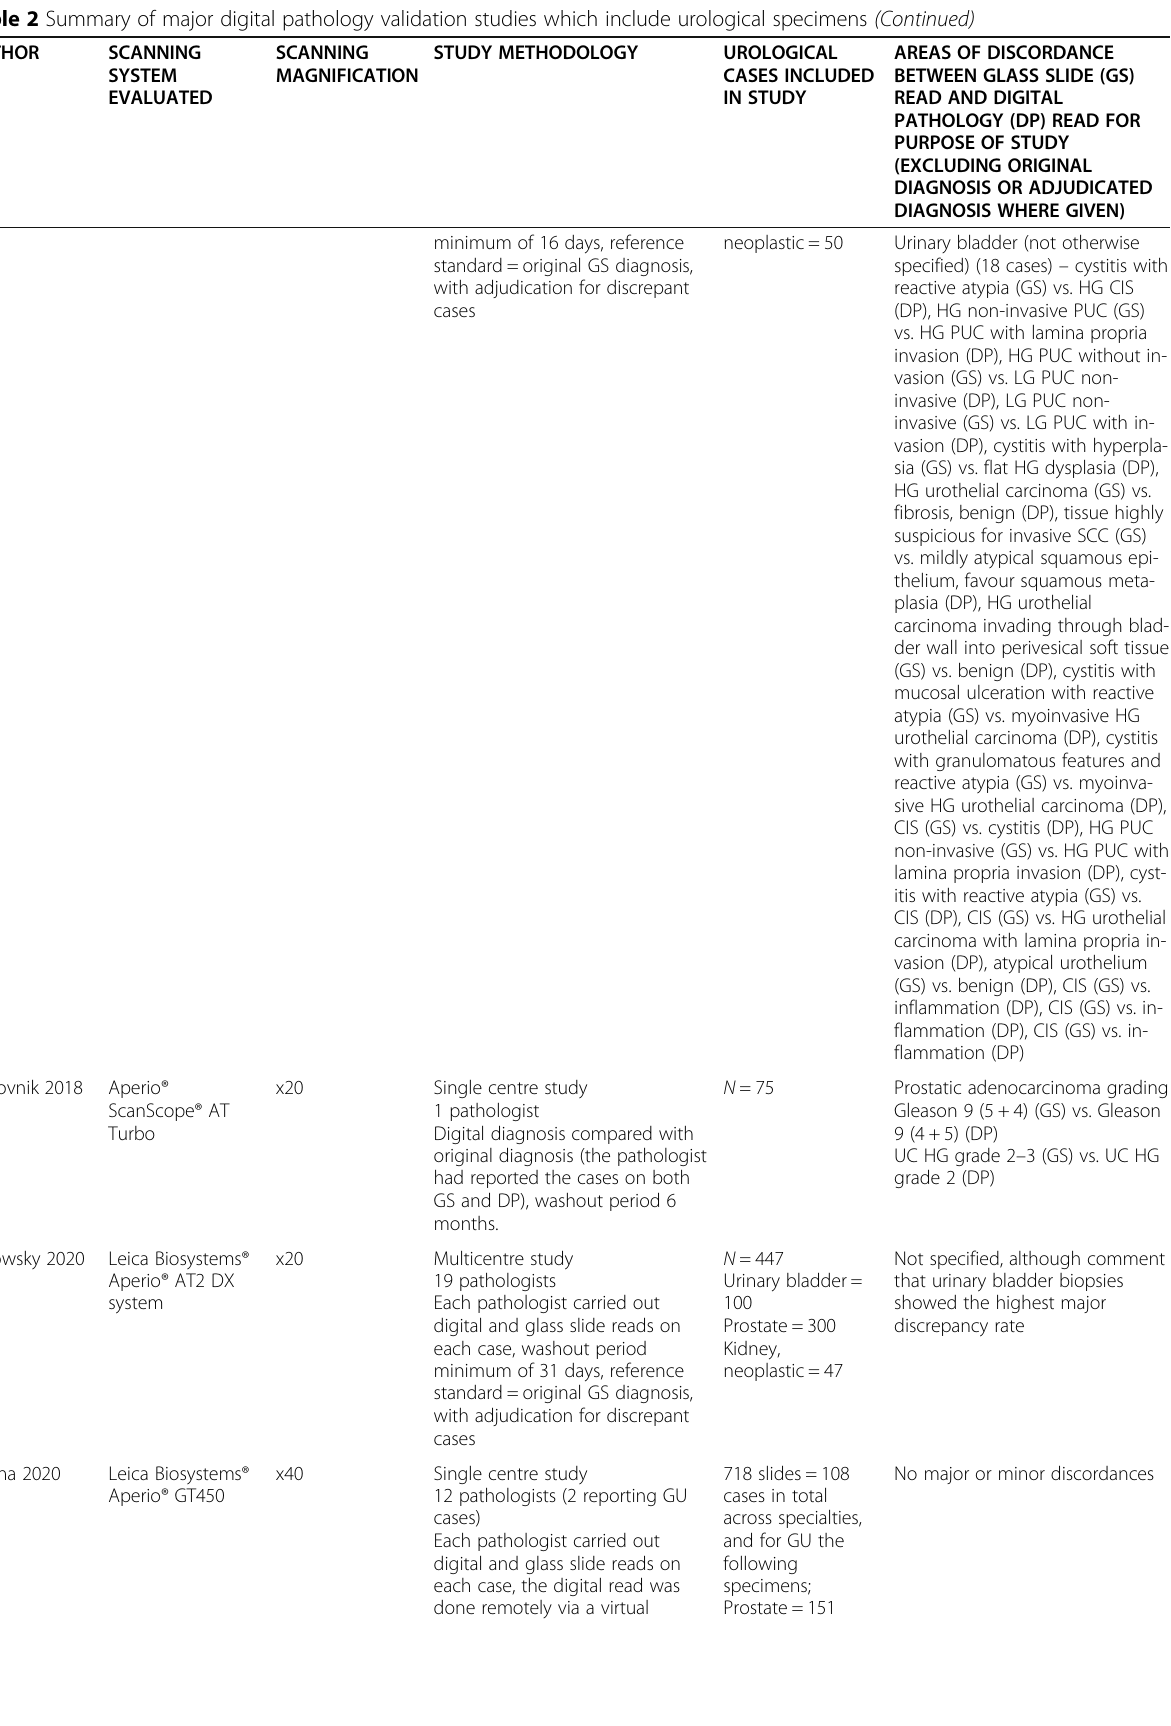
Table 2 Summary of major digital pathology validation studies which include urological specimens